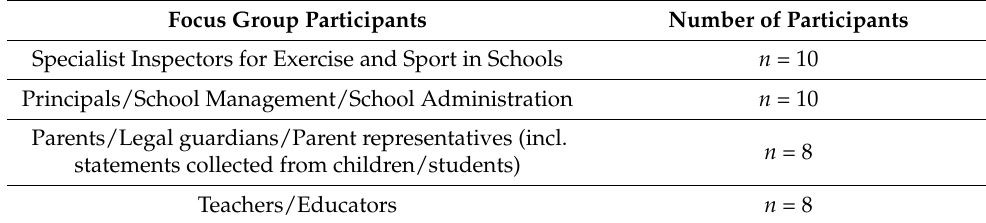
Table 2. Online focus group participants.